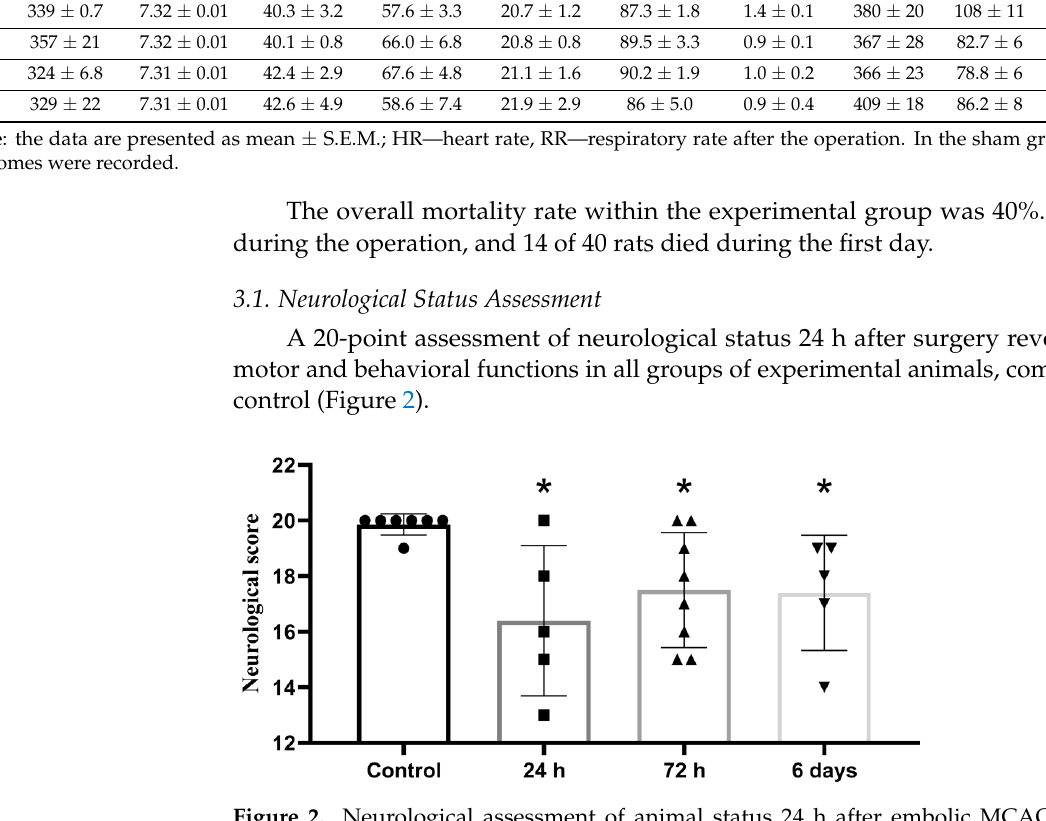
Figure 2. Neurological assessment of animal status 24 h after embolic MCAO; 20-point scale, *—significant difference vs control ( p ≤ 0.05, Mann-Whitney U-criterion). The data is presented as mean with standard deviation.